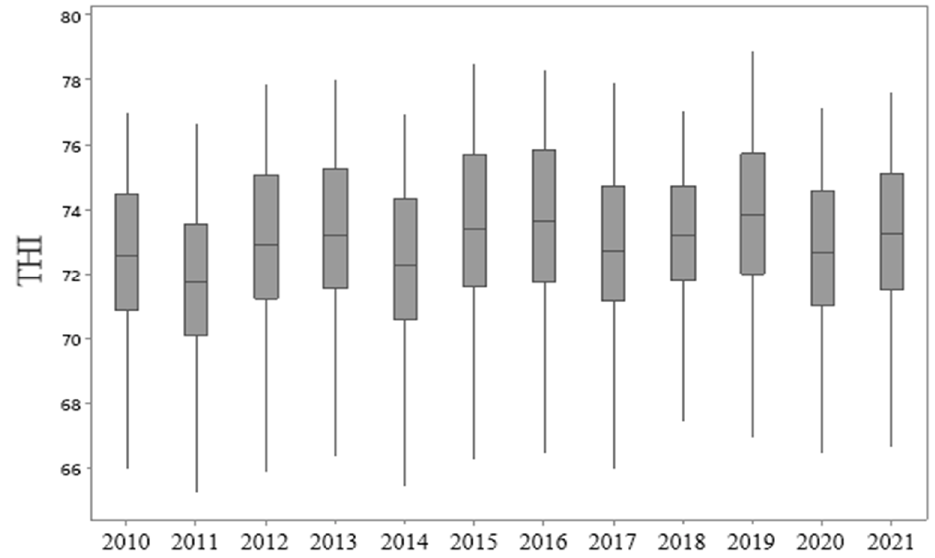
Figure 2. Boxplot of the annual THI of the meteorological stations over the years.